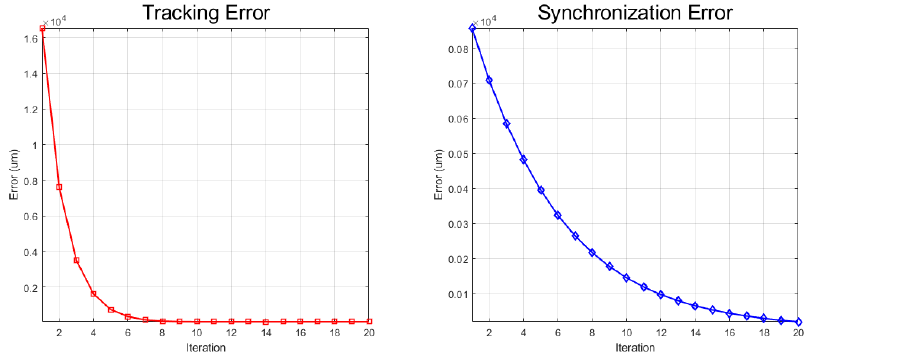
Figure 8. RMS error for tracking and synchronizing with gantry type testbed.